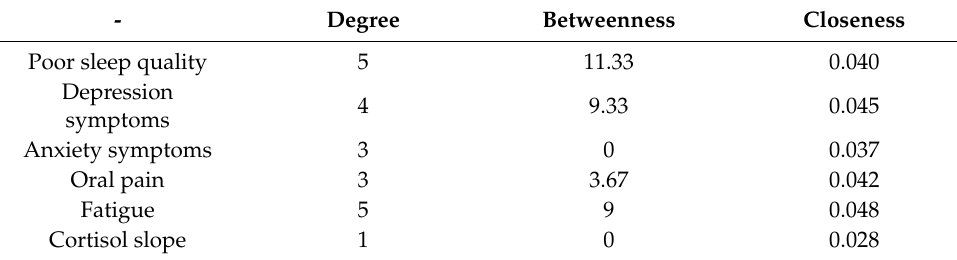
Table 2. Centrality indices of the network model.